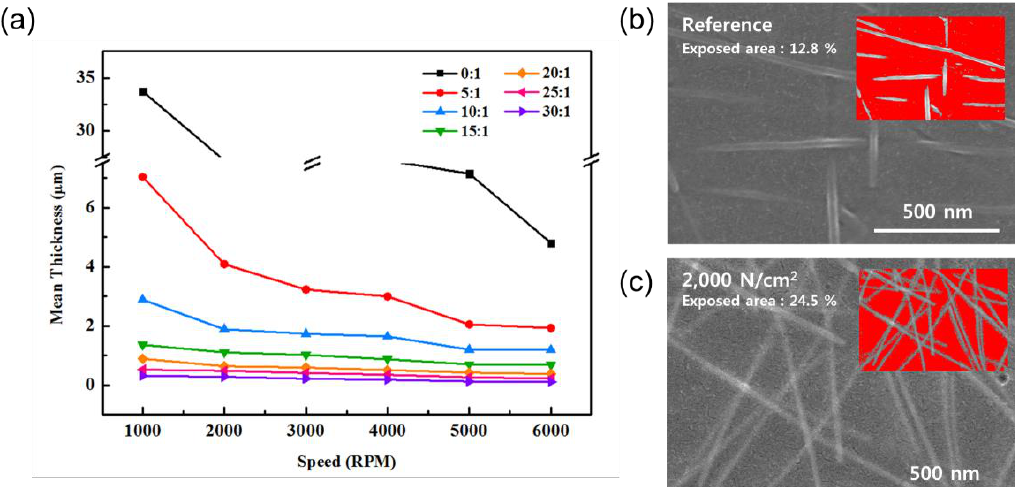
Figure 7. ( a ) The thickness of the AgNW-embedded polydimethylsiloxane (PDMS) film using various weight ratios (from 1:0 to 1:30) of PDMS:Butanol as a function of the spin speed. SEM images of AgNWs exposed to the outside of PDMS for ( b ) the 3D AgNW network and ( c ) the 2D Ag nanomesh (pressurized at 2000 N/cm 2 ).